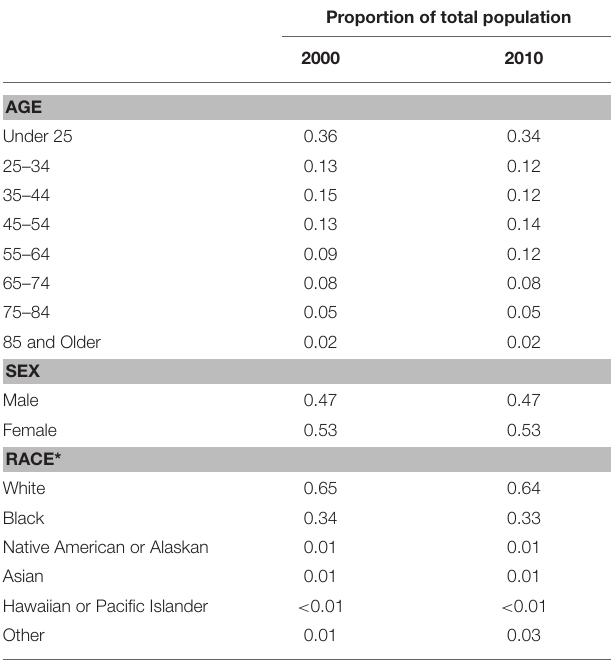
TABLE 4 | Age, sex, and racial composition of the raniteville study population from the 2000 and 2010